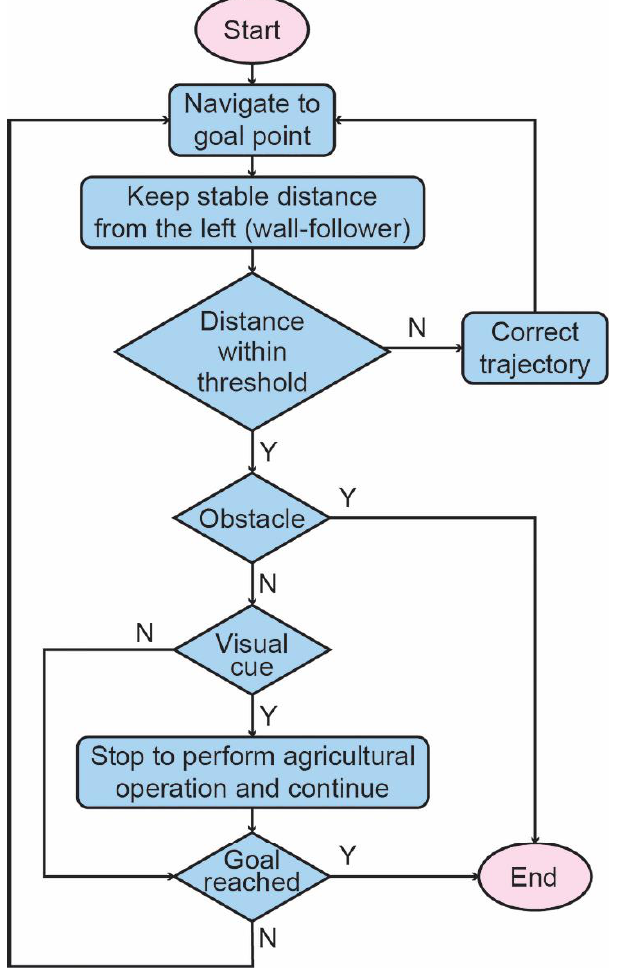
Figure 7. Flow diagram of ARG navigation.